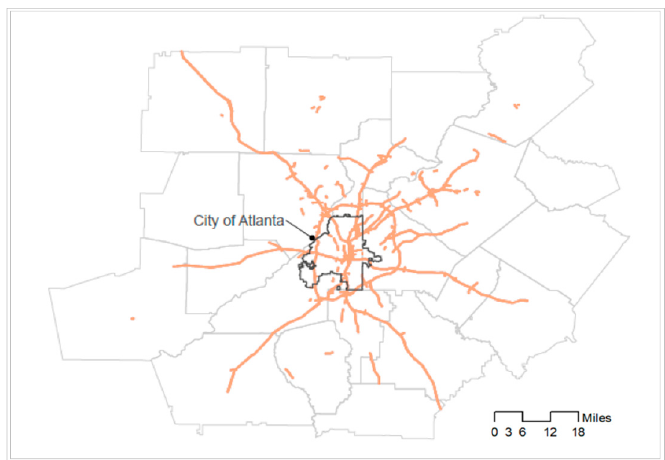
Figure 5. Two hundred-meter buffers around major roads (Note: Individual activity locations are not visualized together on this map to ensure data confidentiality). Table 4. The percentage (%) of the near-road population at di ff erent times of day (by